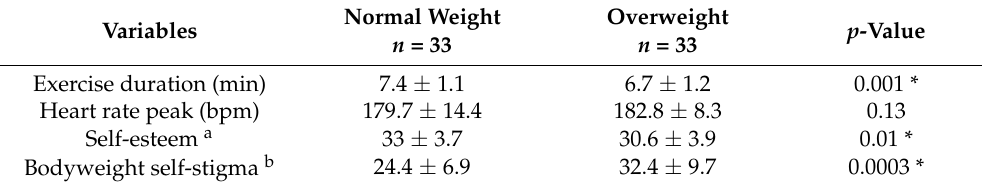
Table 2. Comparison of mean exercise parameters, self-esteem, and weight self-stigma between groups.